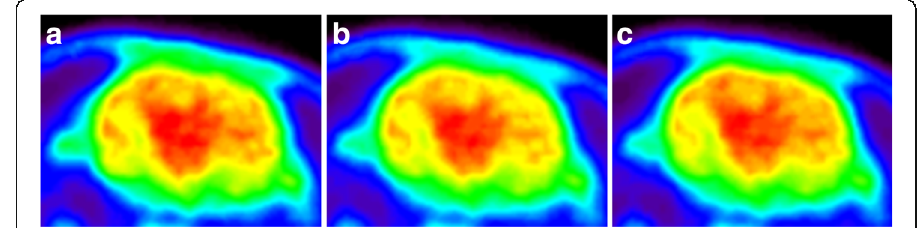
Fig. 4 18 F-FDG PET reconstructed using three different attenuation corrections: CT-AC ( a ), NoBone-AC ( b ), and 31 P-AC ( c